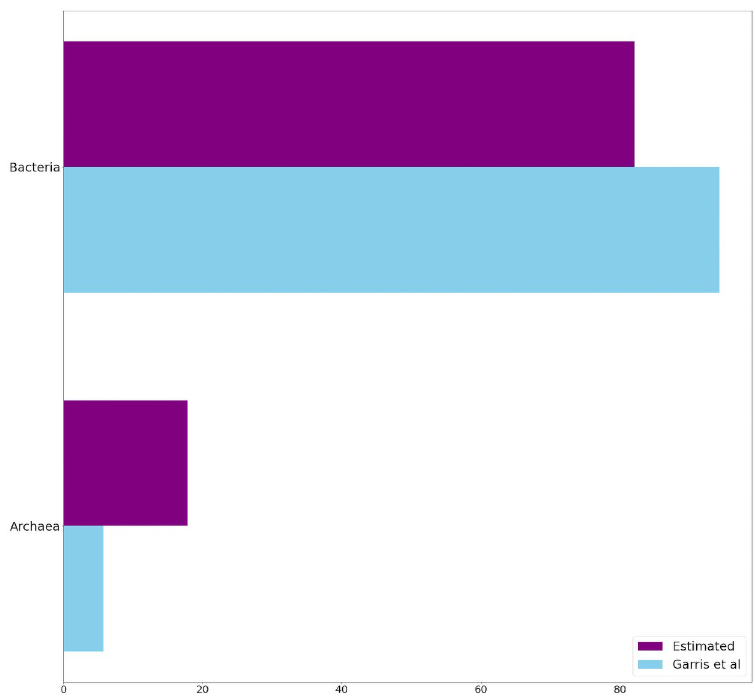
Fig 17. Taxonomic comparison of indicator species at the domain level. Blue bars represent the indicators identified by Garris et al [34]. Purple bars represent the indicators identified by our proposed feature extractor. The horizontal axis represents the percentage of indicators belonging to each species.